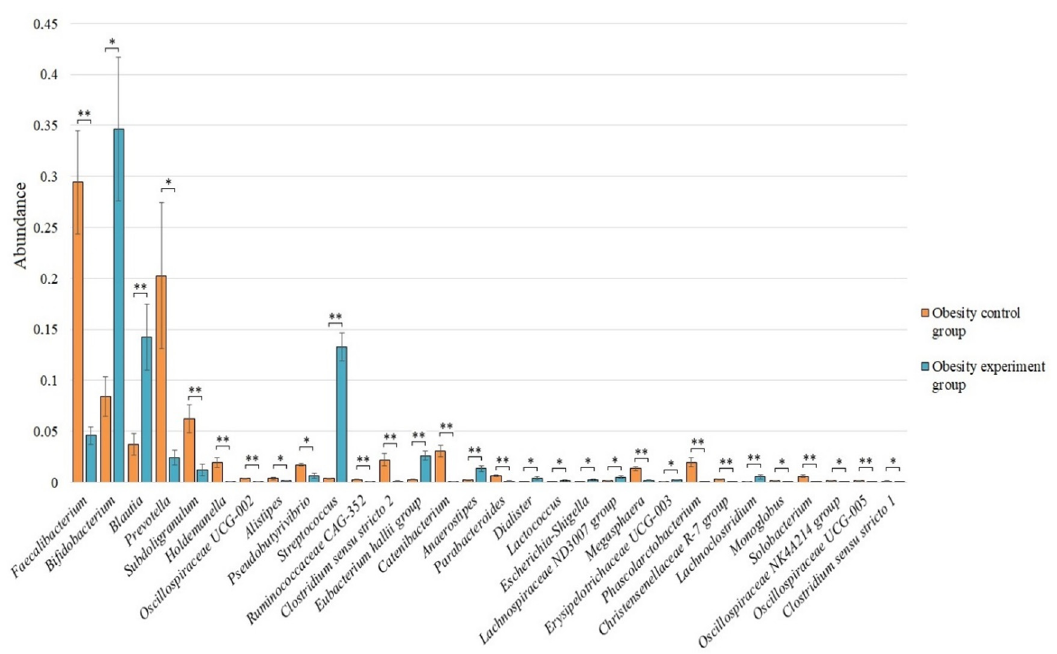
Figure 5. The statistically significant differences in the content of the genera of bacteria among the obesity control group and the obesity group of patients after the intake of lactic acid bacteria. * p < 0.05; ** p < 0.01.